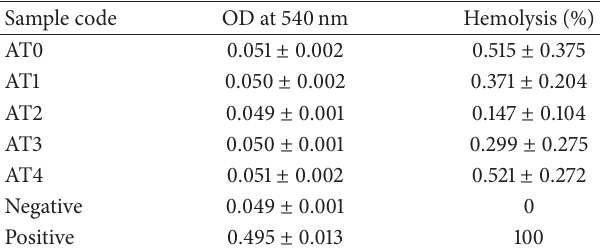
Table 5: Absorbance value measured at 540 nm and percentage of hemolysis of Mg-35Zn-3Ca alloy subjected to heat treatment and artificial aging for different duration of